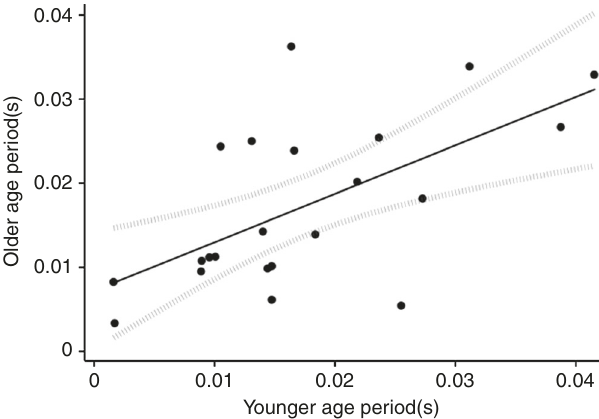
Fig. 2 Consolation tendency is consistent across lifespan. Consolation Fig. 3 Consolation tendency and social competence by subject. A Composite Sociality Index (CSI) was generated for each subject ( N = 44) from grooming and proximity scores, and compared to the tendency to console, calculated by dividing the subject ’ s total number of consolations by its total number of opportunities to